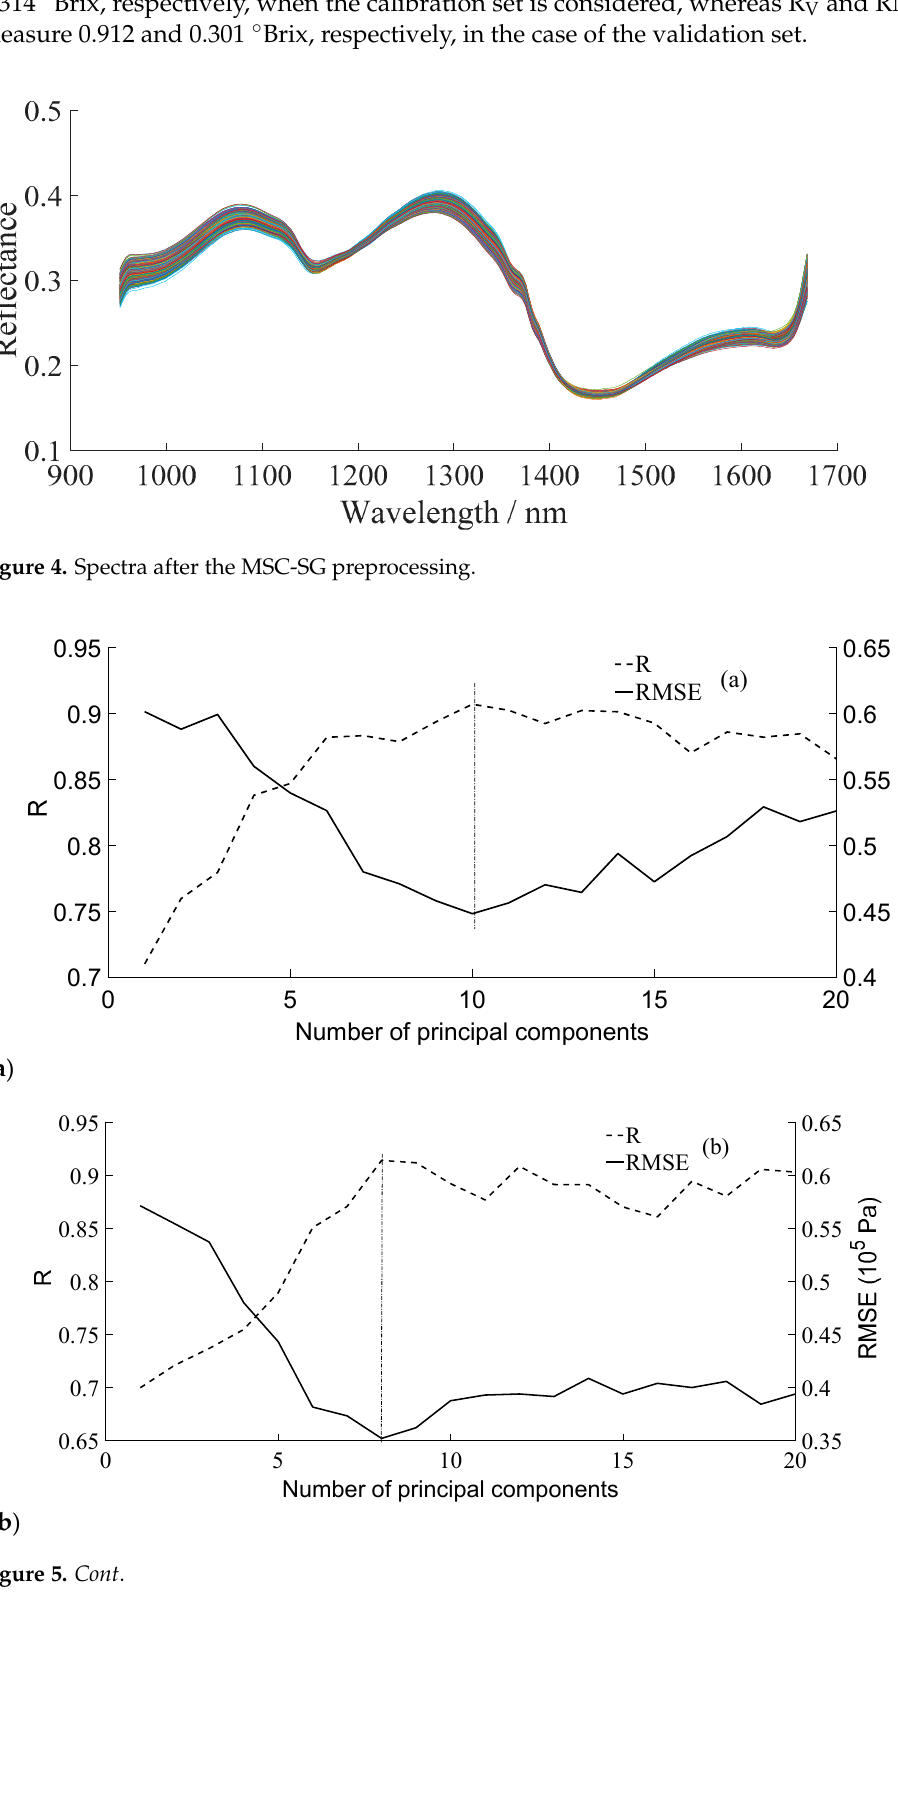
( c ) Figure 5. Selection process of principal components based on MSC-SG. ( a ) Selecting process to estimate the a* value. ( b ). Selecting process to estimate the firmness. ( c ) Selecting process to estimate the SSC. Table 3. Modeling results to estimate the quality parameters for Korla pears. Quality Pa- rameters